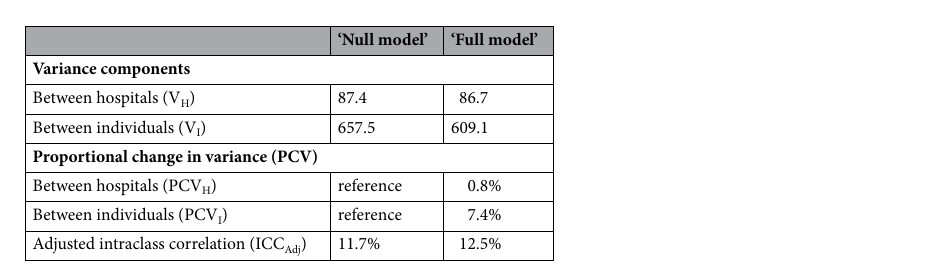
Table 3. Estimates of variability in practice patterns in timing of decompression for acute thoracolumbar